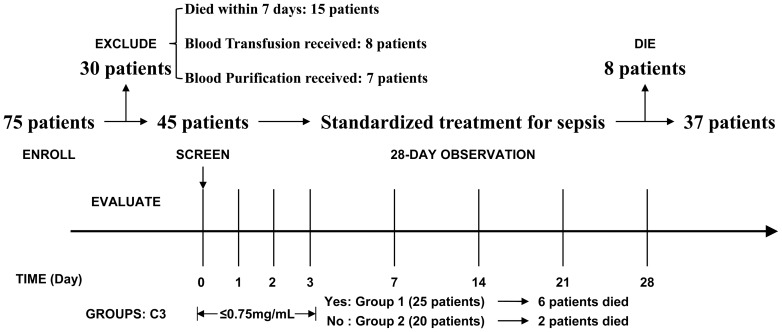
Enrollment and Study design.A total of eight evaluations were performed. Patients were excluded for three medical reasons, including death within seven days after admission, blood transfusion and blood purification within the period of study. All enrolled patients were followed up for 28 days, and 28-day mortality was assessed as the primary outcome.